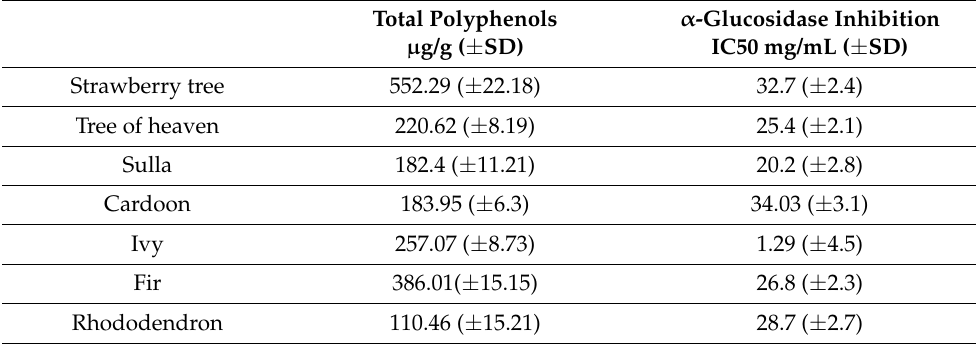
Table 1. Total Polyphenols ( µ g/g) and inhibitory α -glucosidase activity (IC 50 , mg/mL) of the monofloral honeys. Data are mean values ± SD of three